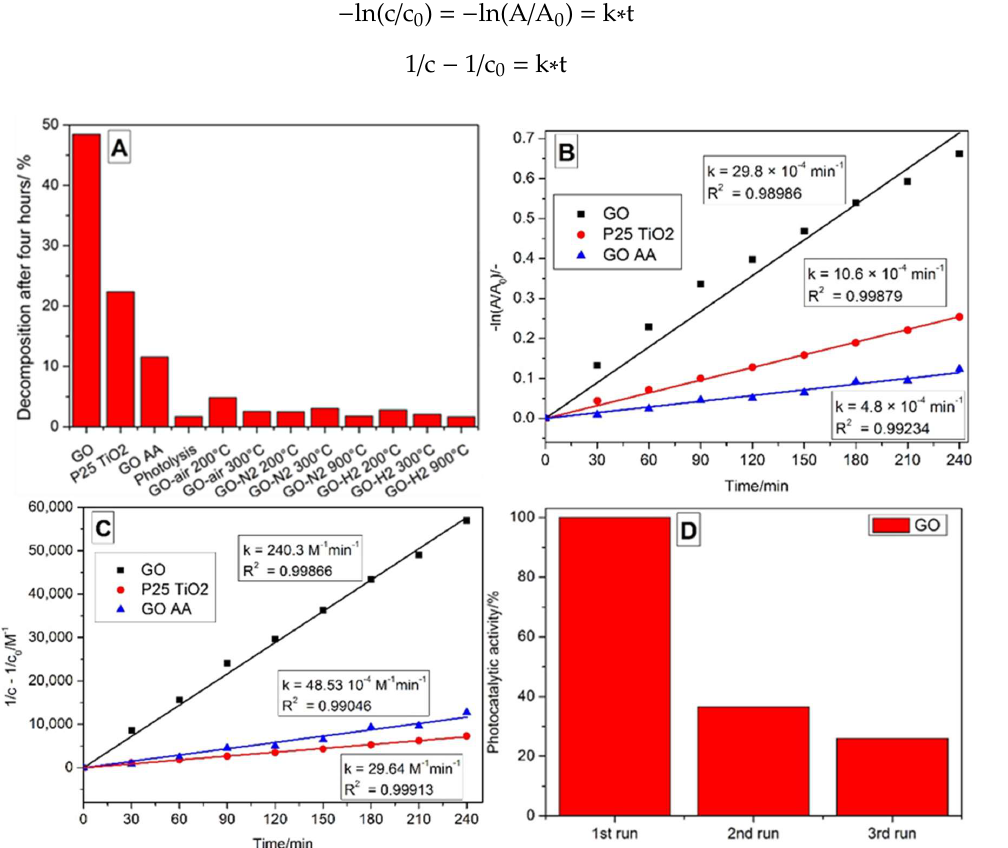
Figure 10. Decomposed amount of methyl orange dye during the photocatalytic experiments ( A ), pseudo first order ( B ) and second order ( C ) linear fitting for the GO, GO AA and P25 TiO 2 samples, and photocatalytic activity of the GO after repeated measurements ( D ).